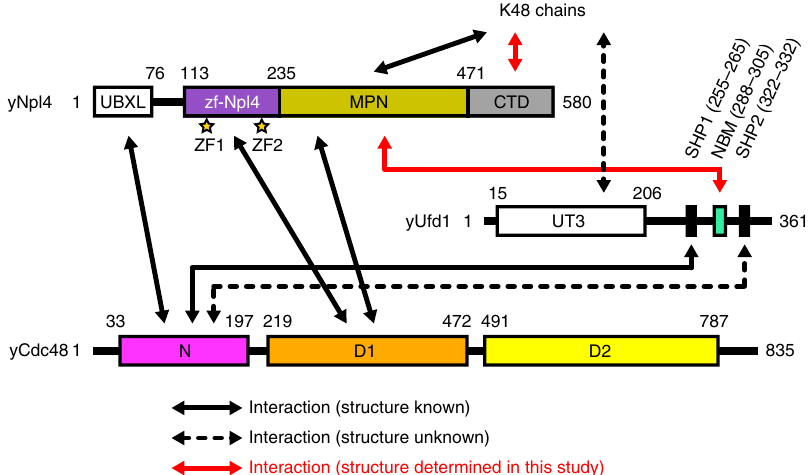
Fig. 1 Domain compositions of S. cerevisiae Npl4, Ufd1, and Cdc48. The zf-Npl4, MPN, and CTD subdomains of yNpl4 are purple, dark yellow, and gray, respectively. ZF1 and ZF2 of yNpl4 are indicated by yellow stars. The NBM region of Ufd1 is turquoise. The N, D1, and D2 domains of Cdc48 are magenta, orange, and